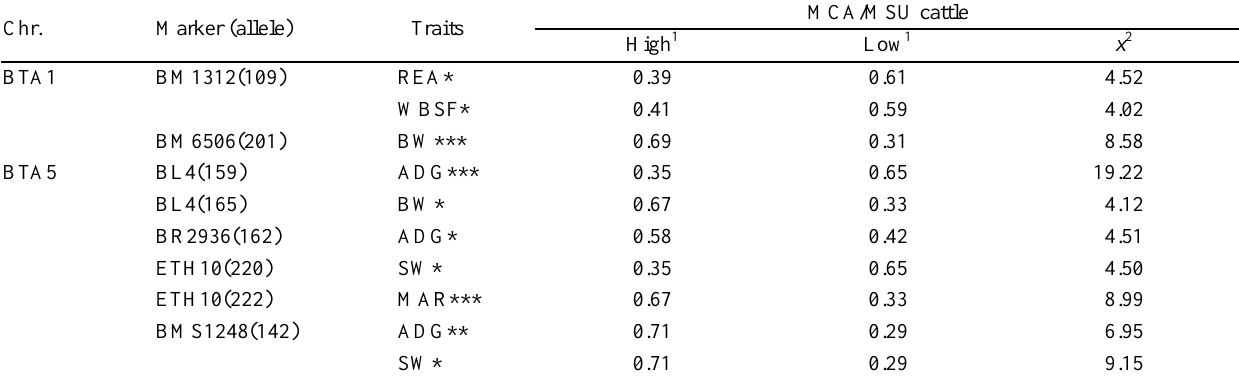
Table 4. Chi-square analyses of allelic frequency differences between high and low phenotypic groups